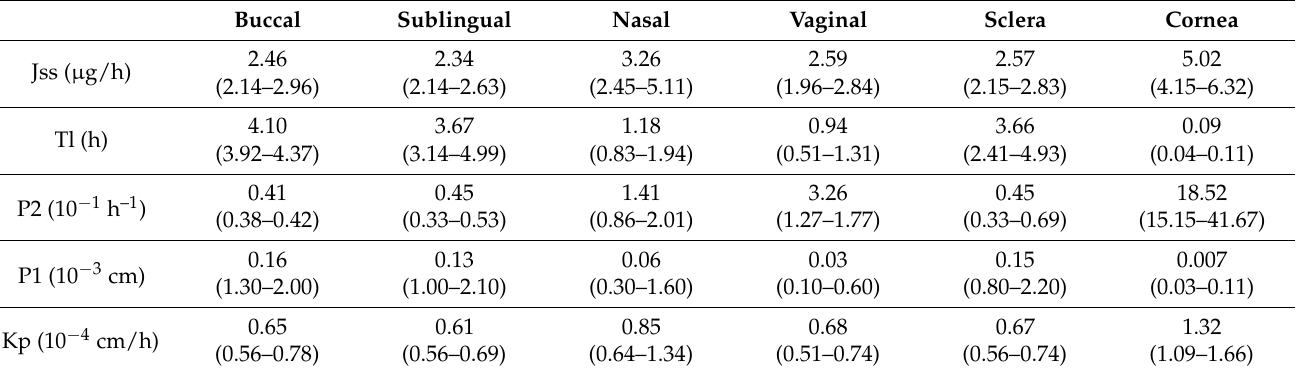
Table 10. The results of the permeation parameters of PF at 6 h from the selected formula in the different mucosal tissues tested, n = 6 each. The results are reported as the median (maximum and